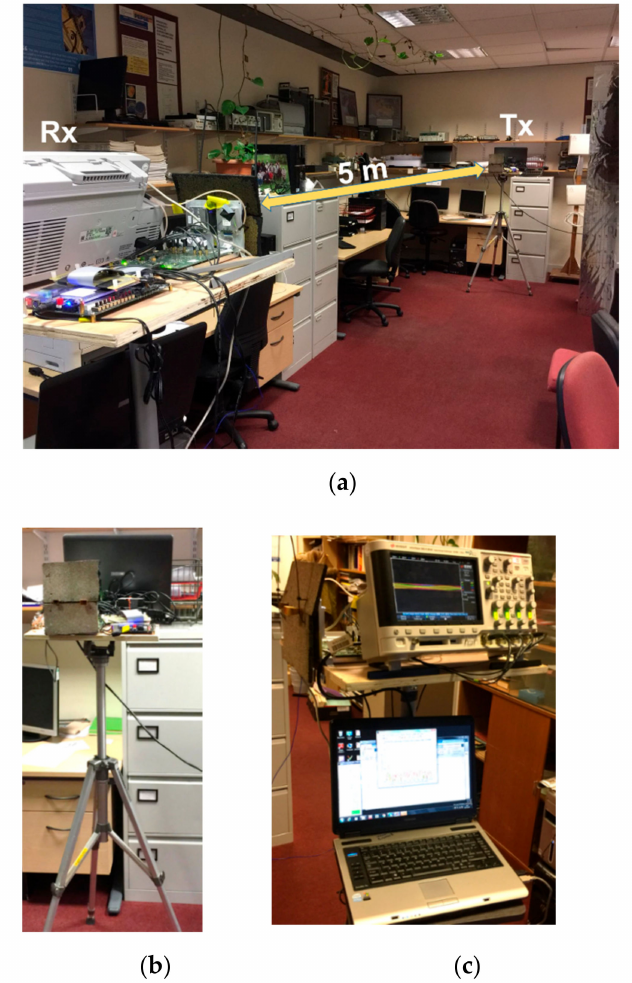
Figure 4. 60 GHz Channel Sounder in Lab B3.26, ( a ) LOS scenario, ( b ) Transmitter, ( c )